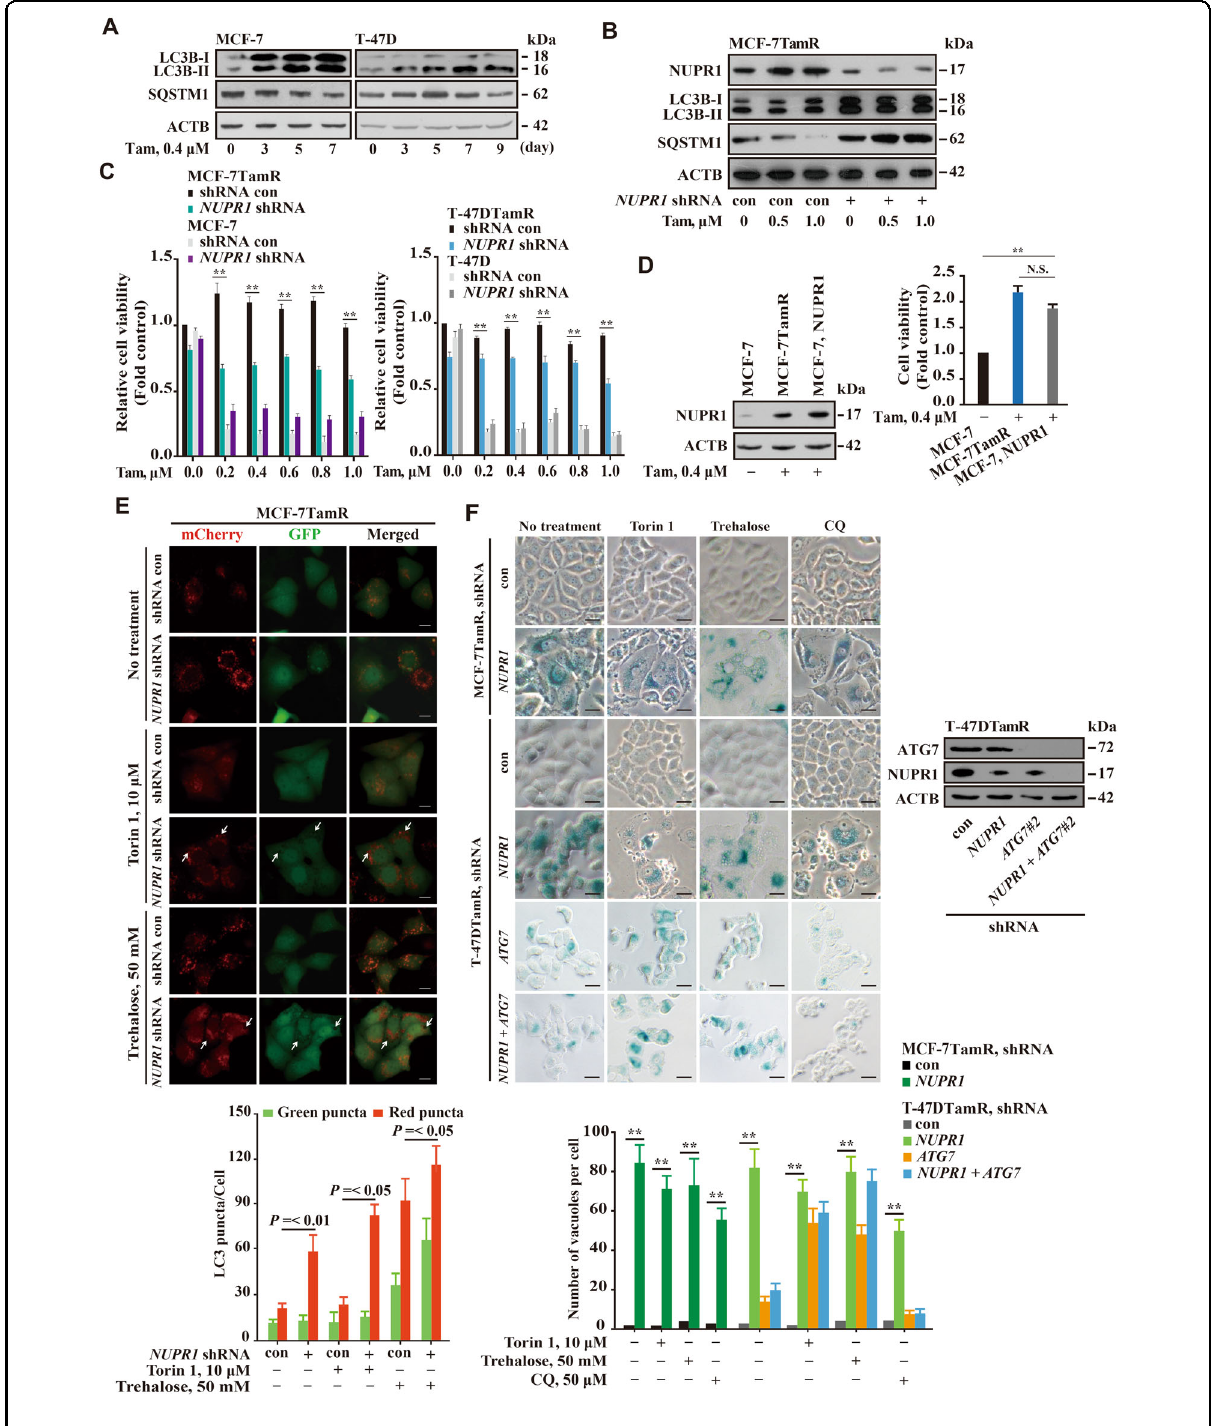
Fig. 2 (See legend on next